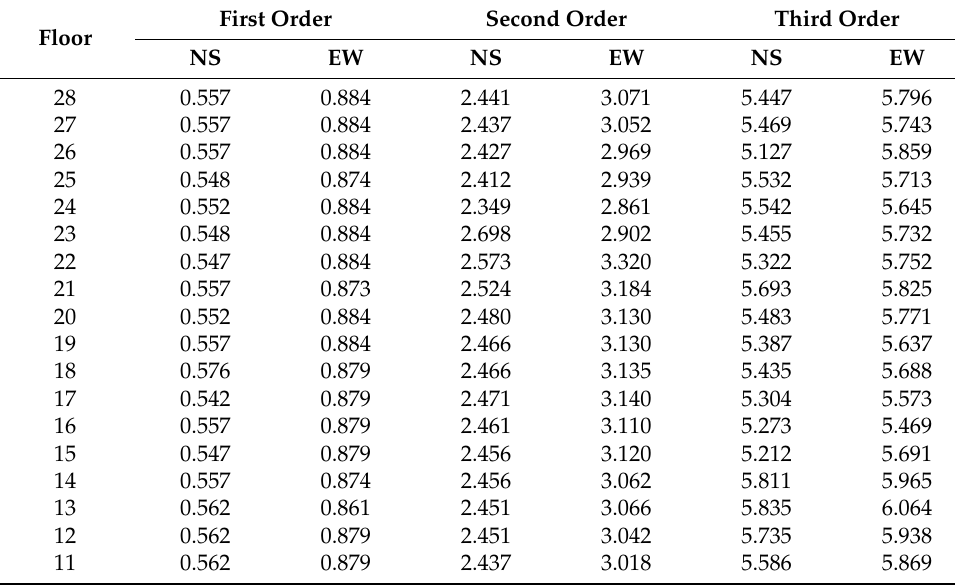
Table 1. The first three-order frequencies in two directions (Unit: Hz).